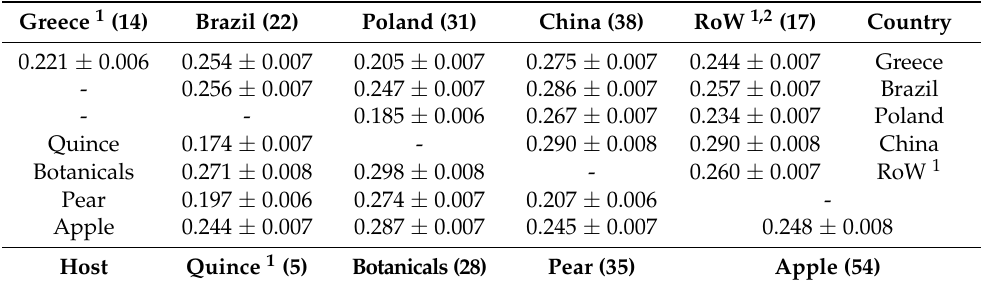
Table 3. Average nucleotide pairwise intra-group and inter-group divergence values ( ± standard deviation) for country of origin groups (upper table) and for a host of origin groups (lower